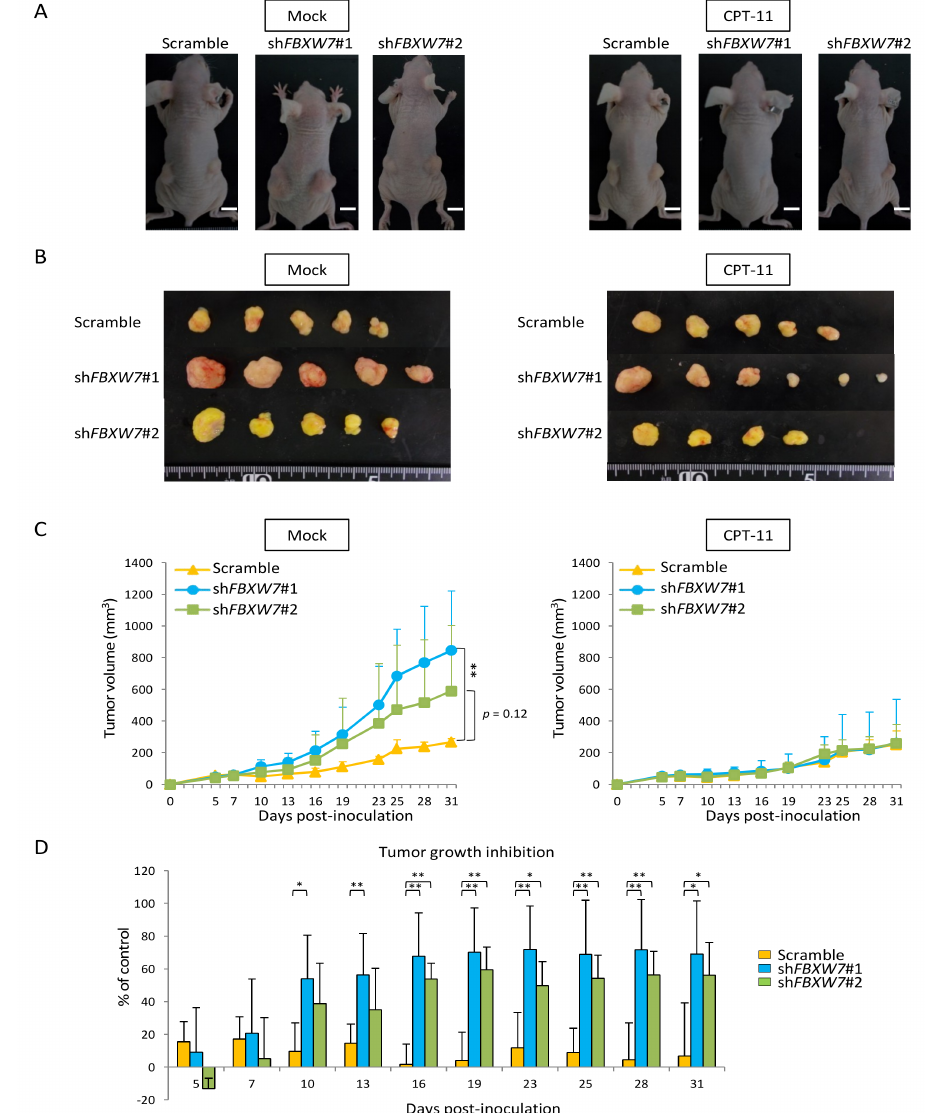
Figure 5. In a xenograft model, FBXW7 knockdown promotes tumor growth and induces tumor inhibition upon treatment with CPT-11. ( A ) Representative images of tumors in nude mice inoculated with control or FBXW7-silenced DLD-1 cells, treated or not with CPT-11, 31 days after inoculation. White scale bars, 1 cm. ( B ) Macroscopic images of the tumors in nude mice inoculated with control or FBXW7 -silenced DLD-1 cells, treated or not with CPT-11, 31 days after inoculation. ( C ) Tumor growth curves of xenografts derived mice inoculated with control or FBXW7 -silenced DLD-1 cells, treated or not with CPT-11. (D) Tumor growth inhibition rates. Results are presented as the means ± standard deviation of at least three independent experiments. * p < 0.05, ** p < 0.01, *** p <